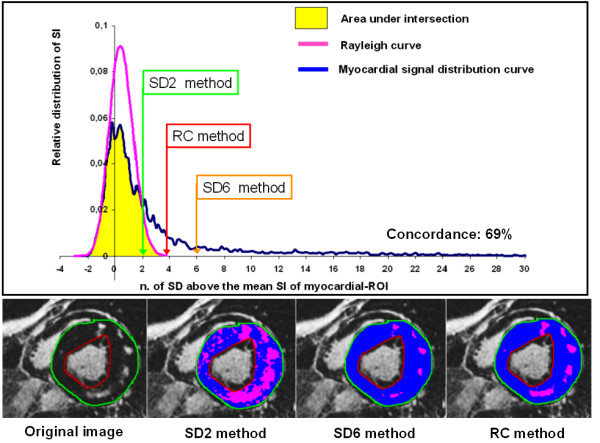
Comparison between the methods in a patient with HCM. Analysis of an original LGE image of a patient with HCM. The upper panel shows the relative distribution of pixel intensity of myocardium (blue line) and the Rayleigh curve derived from the signal of the background-ROI (pink line). The good overlap between the two curves was low (concordance 69%) demonstrating a significant difference between the ideal curve of distribution (Rayleigh) and the measured curve. The thresholds of SD2, SD6 and RC methods are evidenced. In the inferior panels in left to right order are showed the original LGE image contoured, the parametric map derived from the SD2 method, from the SD6 method and from the RC method. In this case SD2 committed a large overestimation of enhancement and SD6 a slight underestimation as evidenced in the graph and judged by the investigators by the comparison between the parametric map and the original image.